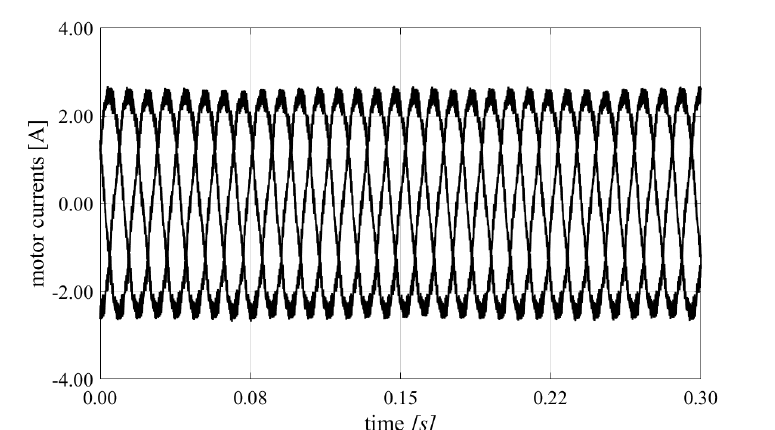
Figure 8. Numerical result: motor currents achieved with the proposed SVM based on Equation (22), when m = 0.94, v ∗ = v ∗ = 200 V, and T l = 3.5 C1 C2